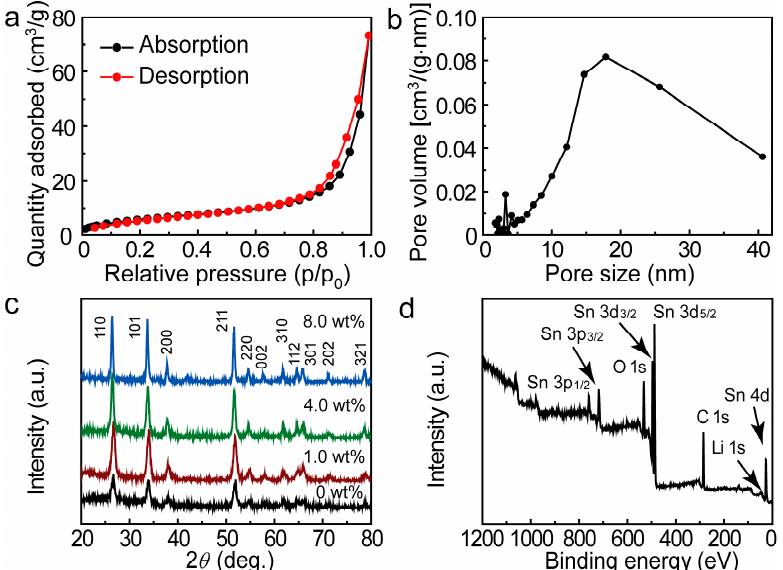
Figure 2. ( a ) Nitrogen adsorption/desorption isotherms; ( b ) DFT pore-size distribution plot of 1.0 wt % Li + -doped SnO 2 porous nanofibers; ( c ) XRD patterns of pristine and Li + -doped SnO 2 porous nanofibers; ( d ) XPS full spectrum of 1.0 wt % Li + -doped SnO 2 porous nanofibers, which confirmed the presence of Li 1s (~55.0 eV) in the doping sample.